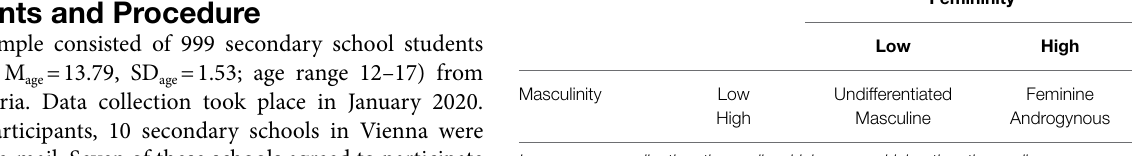
TABLE 1 | Gender role self-concept types.